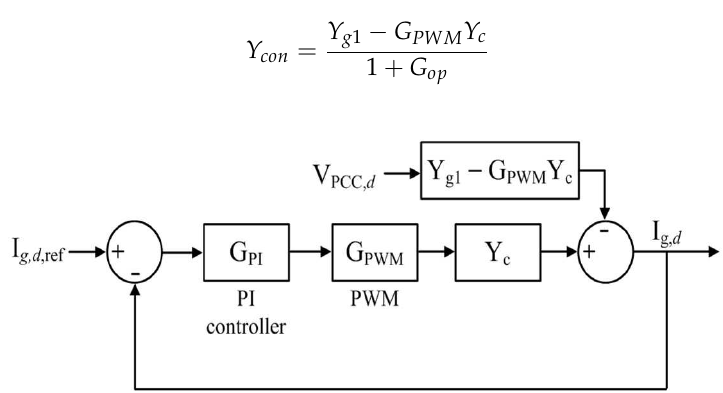
Figure 5. Simplified d -axis current-control block diagram without the coupling term.